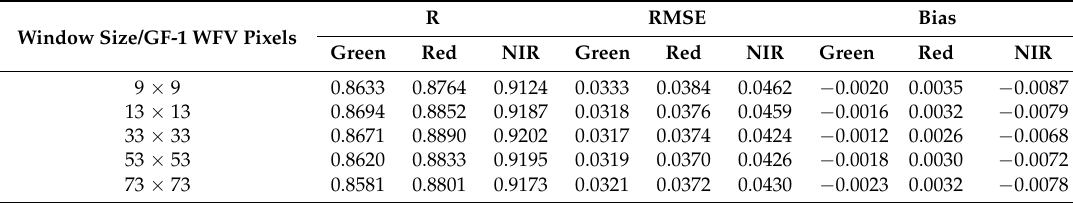
Table 4. Accuracy evaluation of prediction data by combining linear pixel unmixing and STARFM fusion model using different window